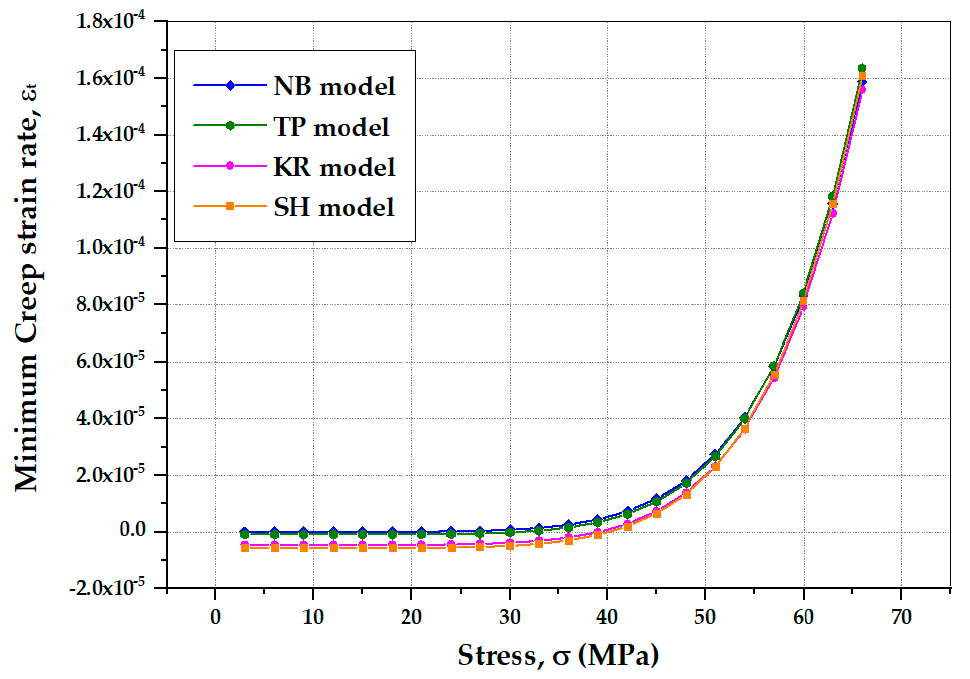
Figure 10. Stress vs. minimum creep strain rate of the models.